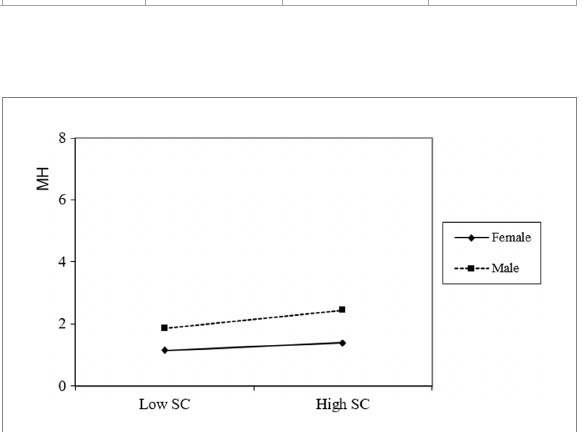
FIGURE 4 The moderating effect of gender on the association between self-compassion and mental health.